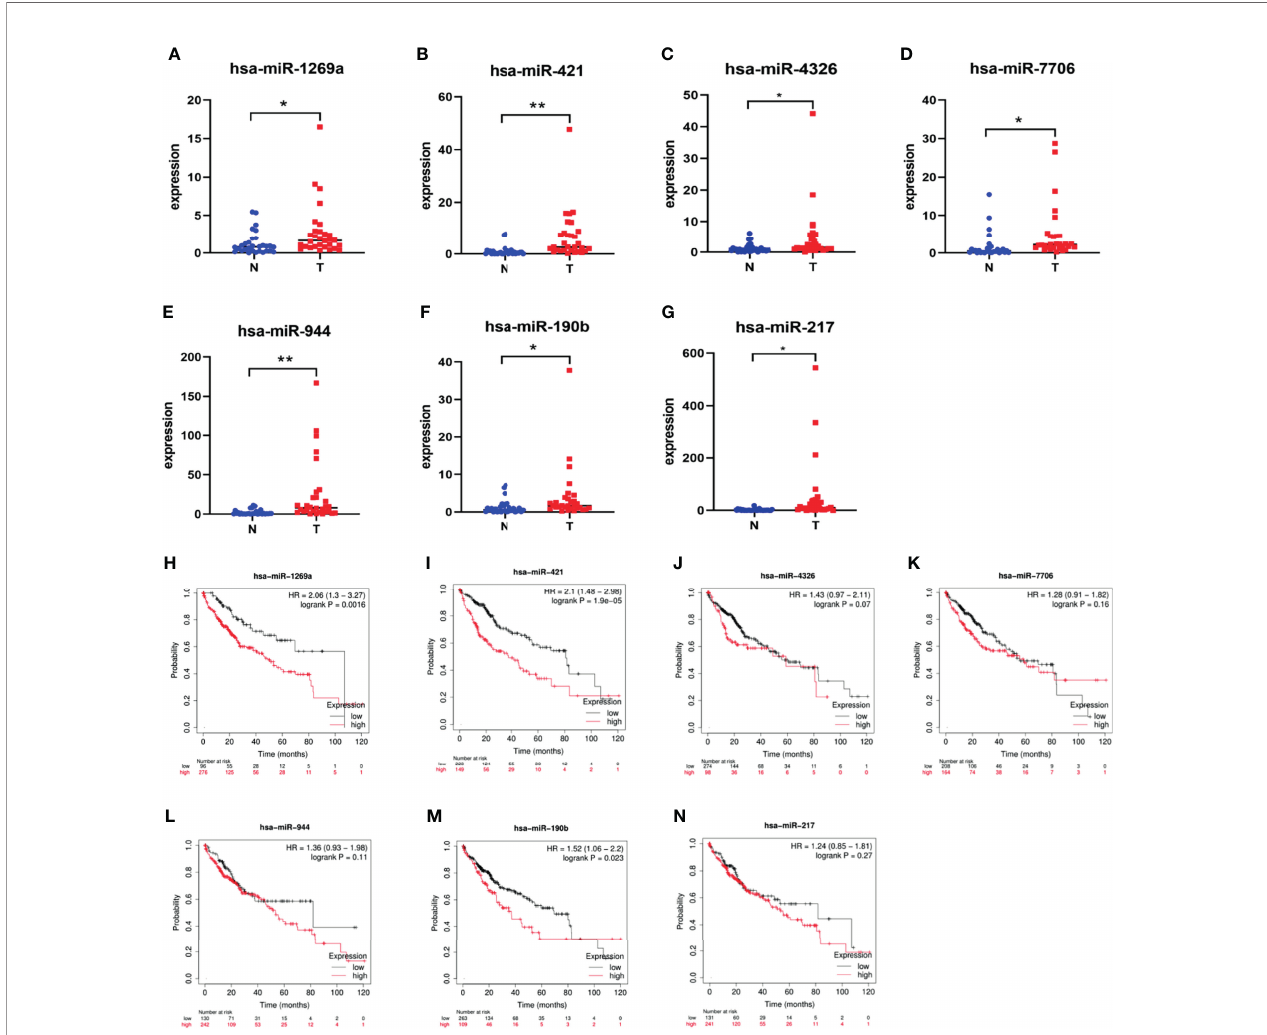
FIGURE 7 | Dif-miRNAs expression in tissue and K-M survival analysis of overall survival (OS) rate (A) has-miR-1269a Up-regulation in HCC (* P < 0.05); (B) has-miR- 421 Up-regulation in HCC (** P < 0.01); (C) has-miR-4326 Up-regulation in HCC (* P < 0.05); (D) has-miR-7706 Up-regulation in HCC (* P <0.05); (E) has-miR-944 Up- regulation in HCC (** P < 0.01); (F) has-miR-190b Up-regulation in HCC ( P < 0.05); (G) has-miR-217 Up-regulation in HCC (* P < 0.05); (H) Correlation of hsa-miR- 1269a with OS ( p < 0.05); (I) Correlation of hsa-miR-421 with OS (* p < 0.05); (J) Correlation of hsa-miR-4326 with OS; (K) Correlation of hsa-miR-7706 with OS; (L) Correlation of hsa-miR-944 with OS; (M) Correlation of hsa-miR-190b with OS ( p < 0.05); (N) Correlation of hsa-miR-217 with OS.